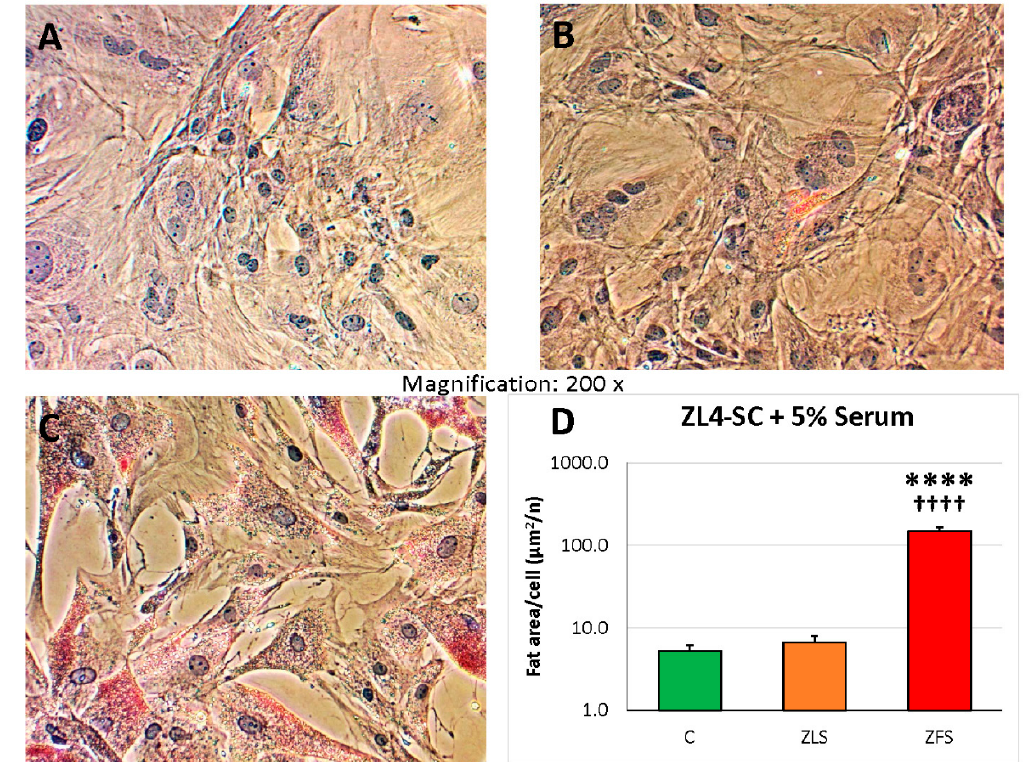
Figure 2. The fat infiltration of ZL4-SC caused by ZFS was similar to the one experienced by the ZF4-SC in Figure 1, with negligible infiltration by ZLS, like in no rat serum addition, indicating a similar response of both MDSC to ZFS. ZL4-SC were incubated as the ZF4-SC in Figure 1 with no addition ( A ), or added ZLS ( B ), or ZFS ( C ), then stained with Oil Red O, and pictures were taken as in Figure